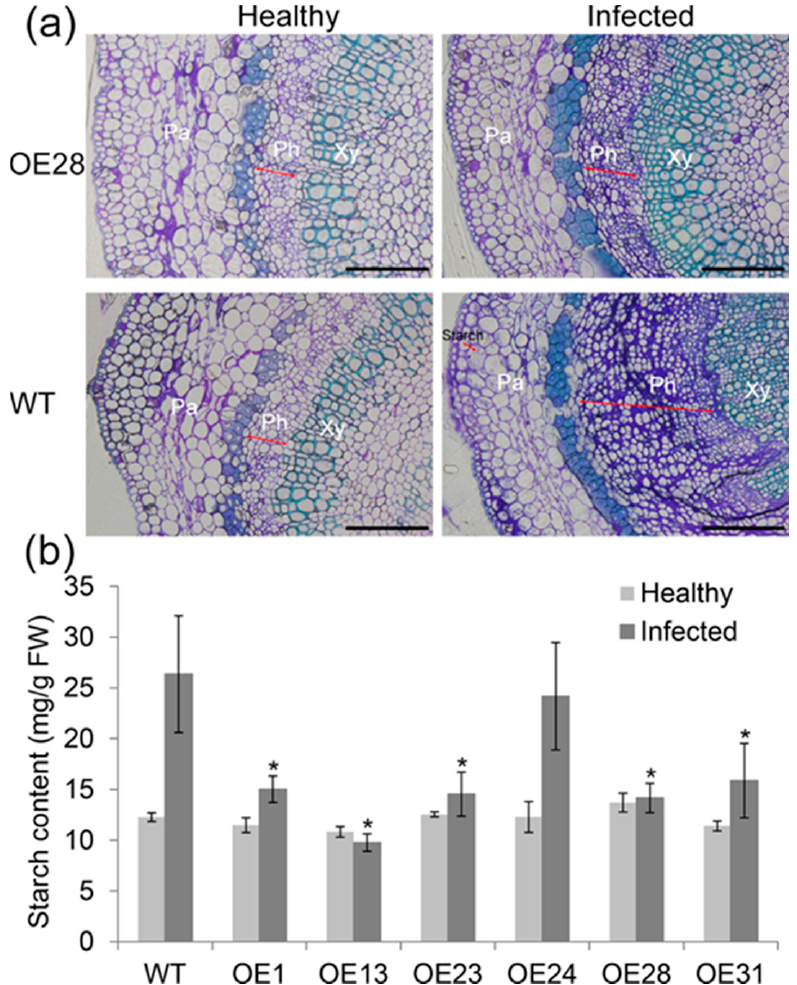
Figure 4. Phloem and starch changes in response to Candidatus Liberibacter asiaticus (Las) in the leaves of transgenic plants. ( a ) Anatomical analysis of the midrib phloem tissues of infected and control leaves 24 months after Las infection. The midribs were collected from the leaves with representative symptoms shown in Figure 3a. The slides were stained with methylene blue- azure A and basic fuchsin. Phloem over-proliferation and starch particles (arrows) were observed predominantly in the Las-infected WT leaves. ( b ) The starch contents in leaf tissues 24 months after Las infection. Starch contents are expressed relative to fresh weight. The vertical bars indicate the standard deviations of the means of three tests. * represents significant differences from the WT control based on a Tukey’s test ( p < 0.05). WT, wild type; OE#, transgenic plants. Pa, parenchyma; Ph, phloem; Xy, xylem. Bar = 20 µm.